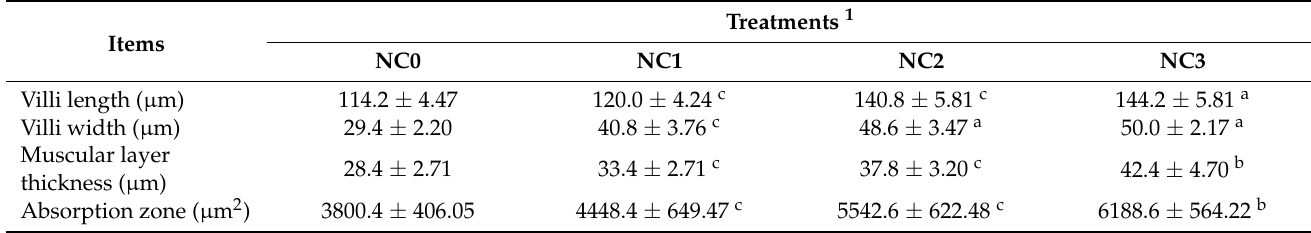
Table 5. Intestinal parameters (Mean ± SE, n = 5) for villi length, villi width, muscular layer thickness, and absorption zone of red tilapia ( Oreochromis sp.) challenged with Aspergillus flavus , at the end of the experiment.